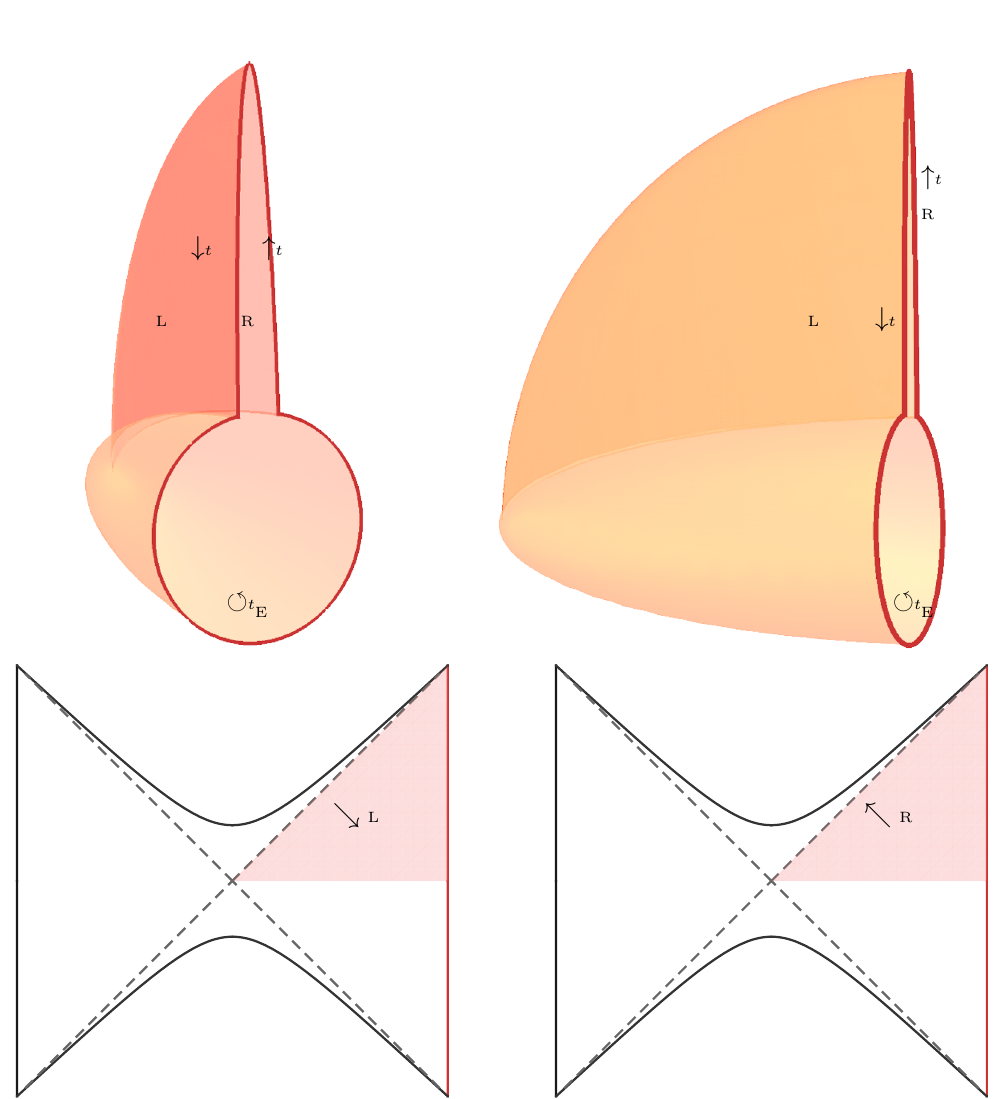
Figure 2 . The two-sheeted complex grSK geometry shown from two di(cid:11)erent perspectives. On the top left we display the boundary thermal SK contour which is (cid:12)lled in the Euclidean portion by the Euclidean black hole geometry (the cigar) and in the Lorentzian section by two copies of the domain of outer communication of the Lorentzian black hole spacetime. The top right panel displays the bulk perspective to emphasize the smooth join of the two sheets of the Lorentzian section. On the bottom panel we illustrate the Lorentzian sections of the geometry on the Schwarzschild-AdSd+1 Penrose diagram. with the regions pertaining to the L and R sheets of the grSK spacetime shaded.